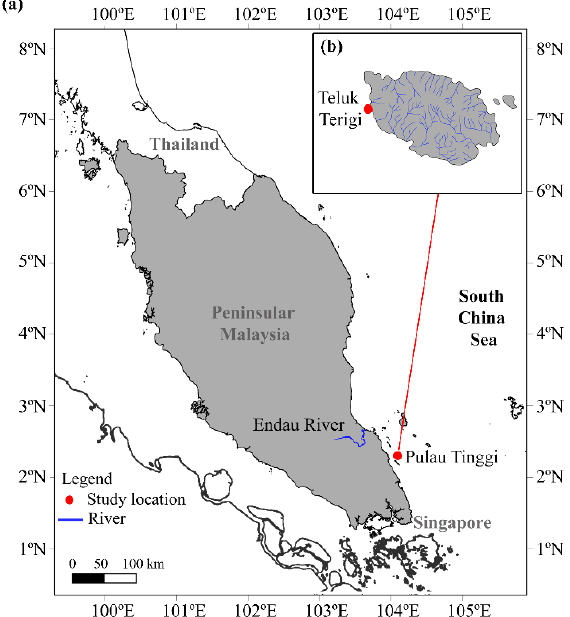
Figure 1. Map shows ( a ) Pulau Tinggi located off the southeastern coast of Peninsular Malaysia with ( b ) the sampling site at Teluk Terigi.